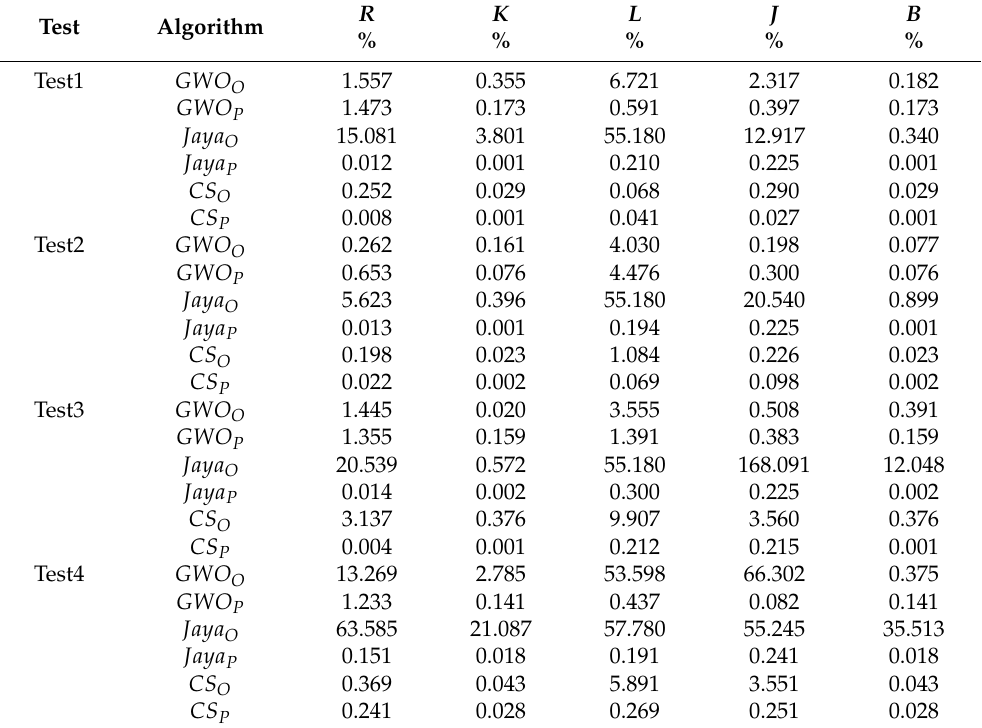
Table 5. The absolute percentage error for test in Motor 1.